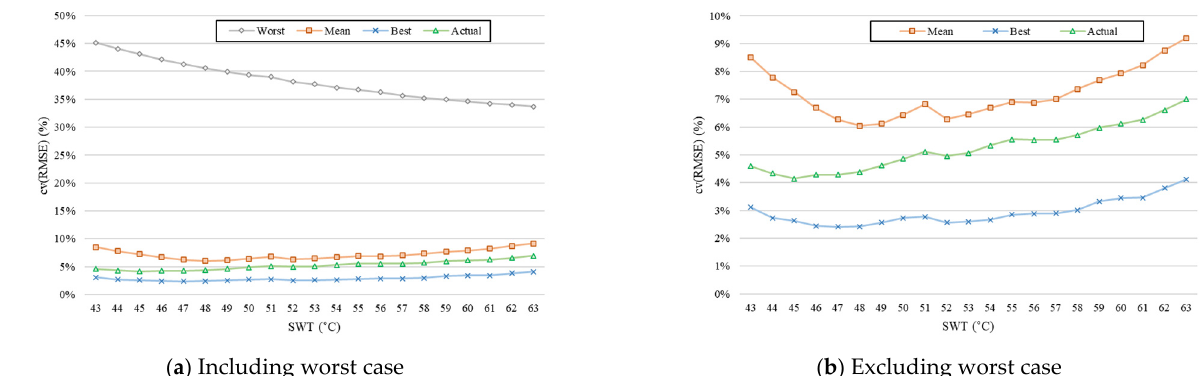
Figure 8. Distribution of the heating load for the supply water temperature.